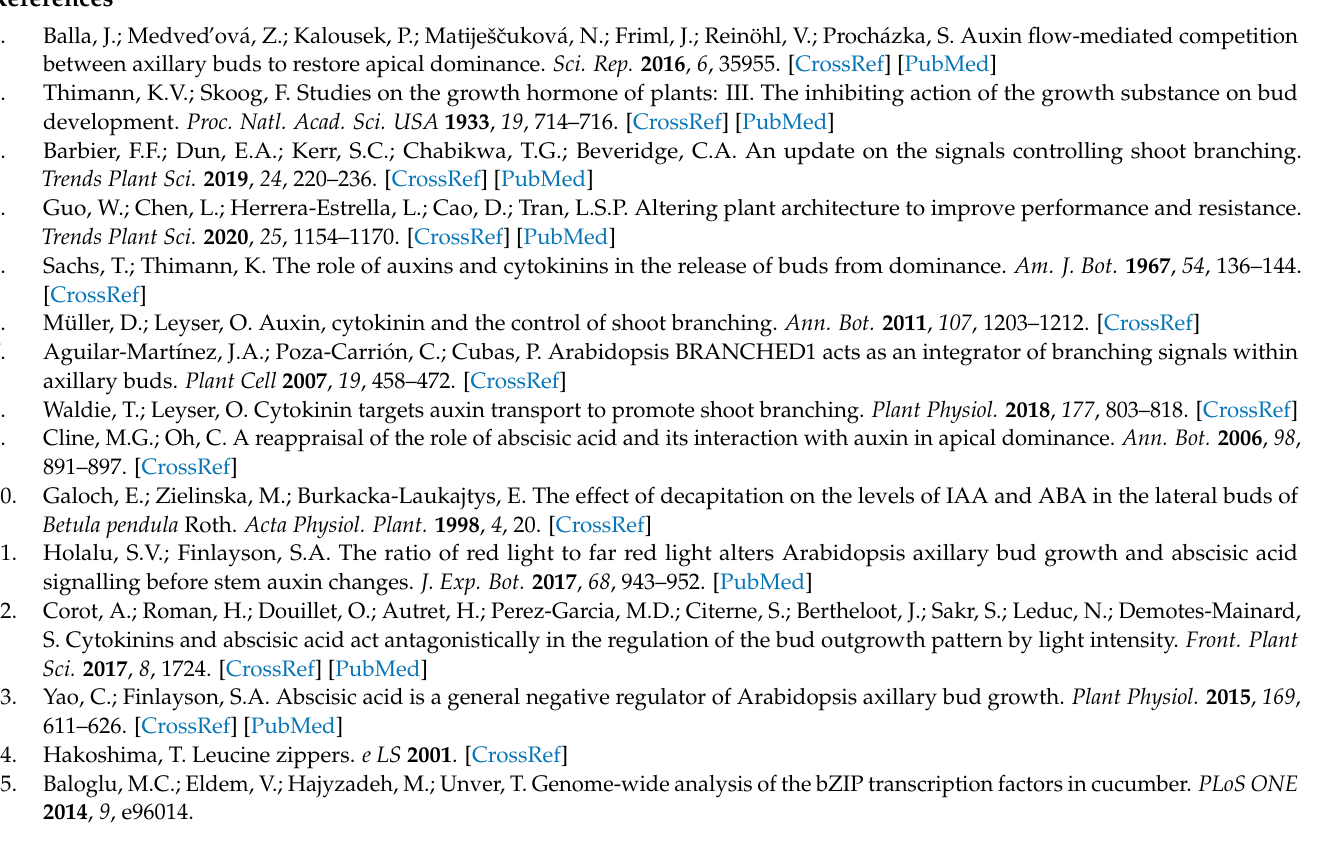
Table S2: Summary of clean reads in the axillary bud transcriptomes of